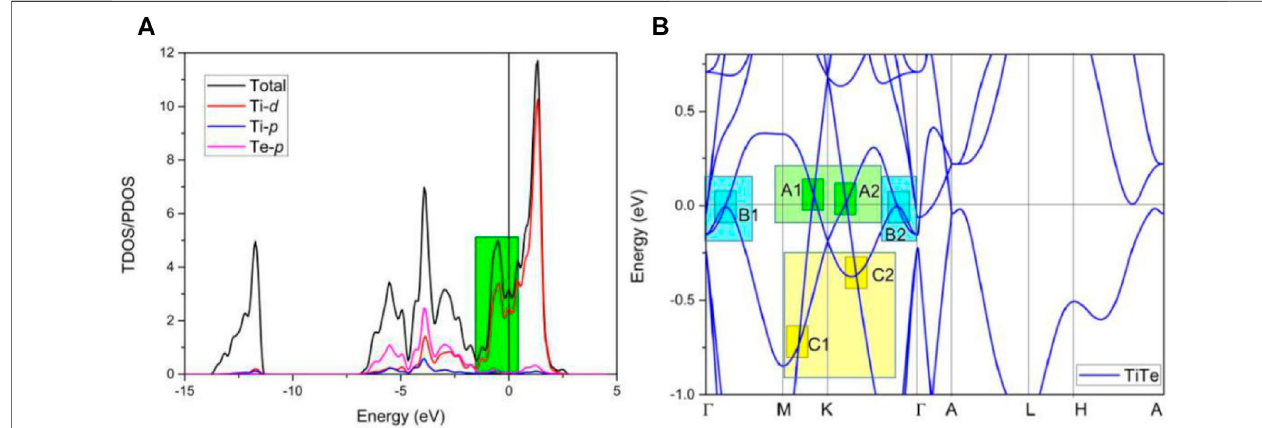
FIGURE 4 | (A) Total and projected density of states and (B) band structure of TiTe bulk.